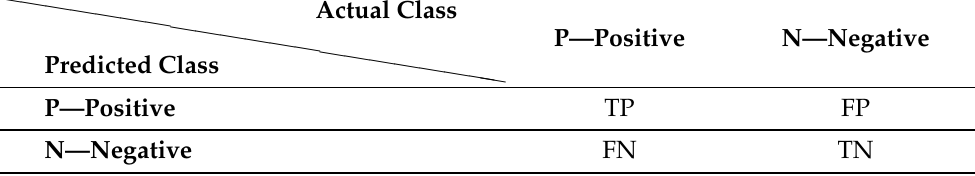
Table 1. Confusion matrix.